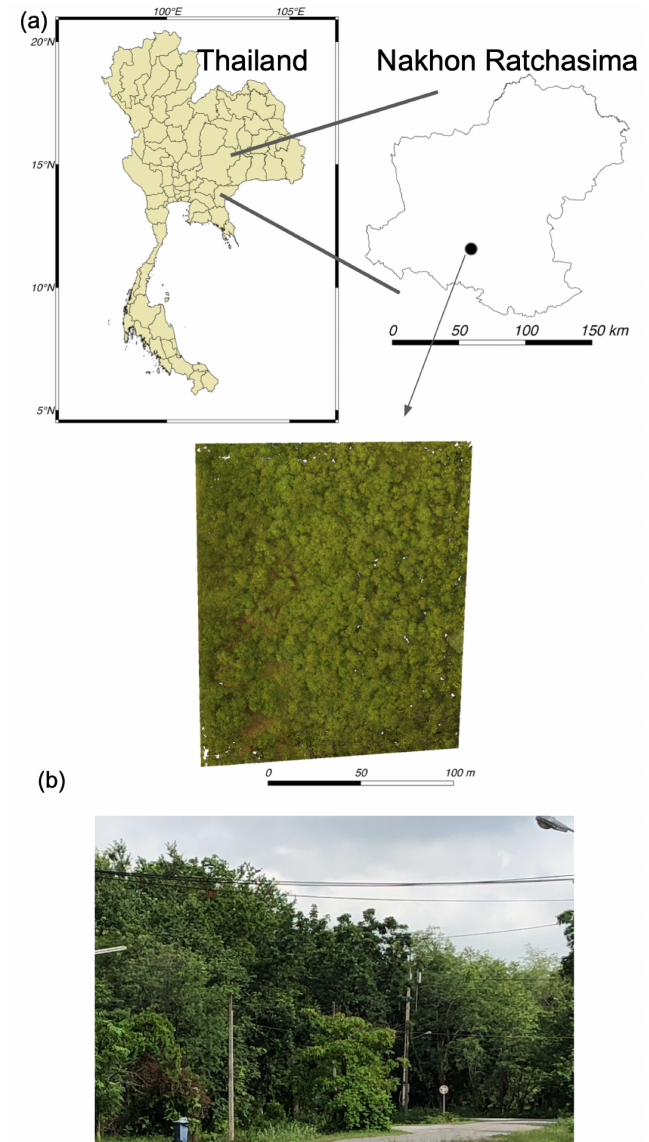
Figure 2. ( a ) The location of the study area and overall the study forest. The area is located in the Suranaree University of Technology in Nakhon Ratchasima, Thailand. The site is dense forest and soil is exposed on some area. The main stand is deciduous dipterocarp forest. ( b ) A photograph taken by near target